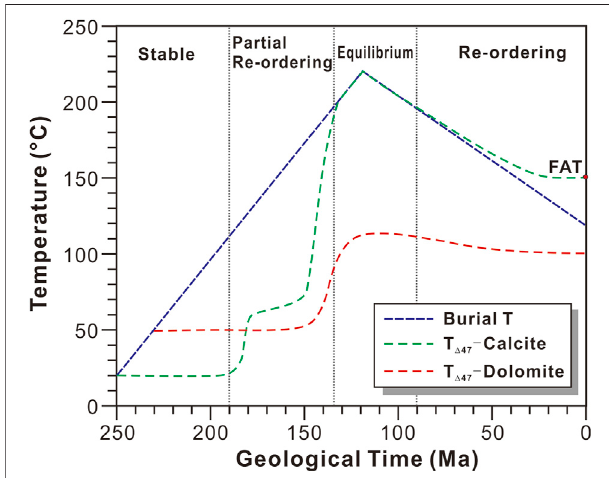
FIGURE5| Thegeneralclumpedisotopetemperature(T Δ 47 )evolutionof the P 2 c-T 1 f dolomite and calcite from the Puguang gas fi eld in the Sichuan Basin, assuming that the maximum burial temperature reached 220 ° C and then decreased to 110 ° C during the late uplift event. The solid-state reordering models for calcite and dolomite are from Stolper and Eiler (2015) and Lloyd et al. (2018), respectively. FAT (cid:1) Final apparent temperature.